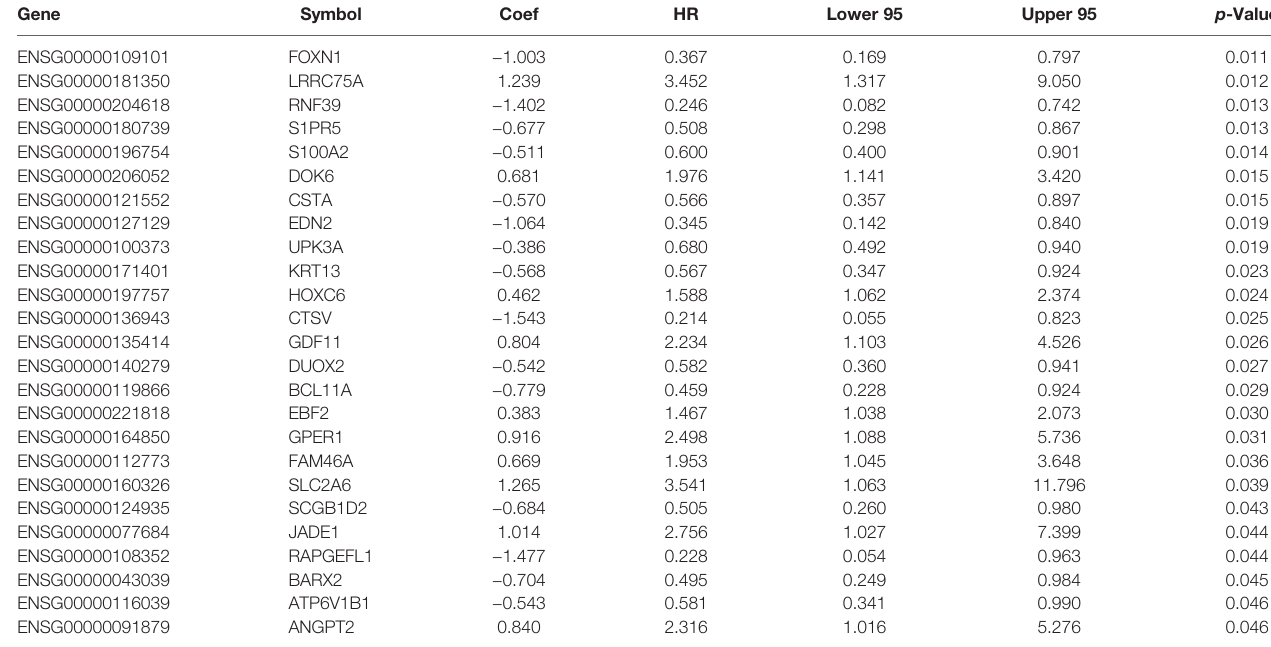
TABLE 2 | Univariate Cox regression analysis of DEGs.